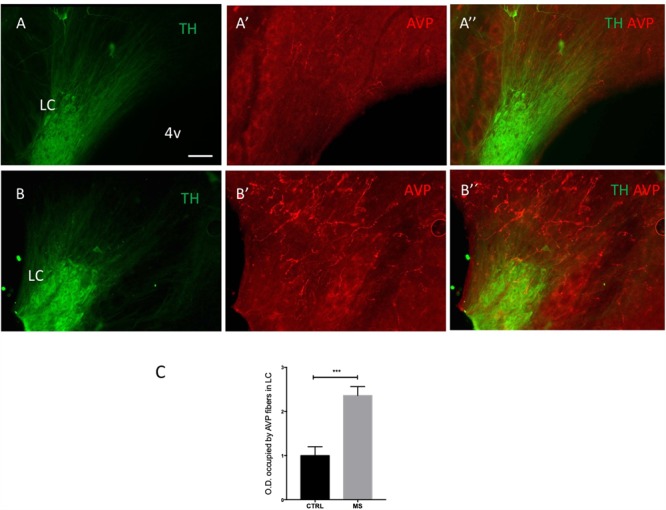
Early life stress in the form of neonatal maternal separation (MS) increases LC AVP immunoreactivity. Photomicrographs of rat brain horizontal sections (around dorso-ventral 7.30 mm), showing immunoreactivity for TH and AVP in the LC of control (As) and MS (Bs) subjects, treated as described in Materials and Methods, Maternal Separation (MS) Protocol. Note that all tissue was processed and imaged under identical conditions. (C) Quantification of AVP immunoreactivity. The columns represent the means and the errors represent the SEM; (n = 5); ∗∗∗p < 0.001. Scale bar: 100 μm.